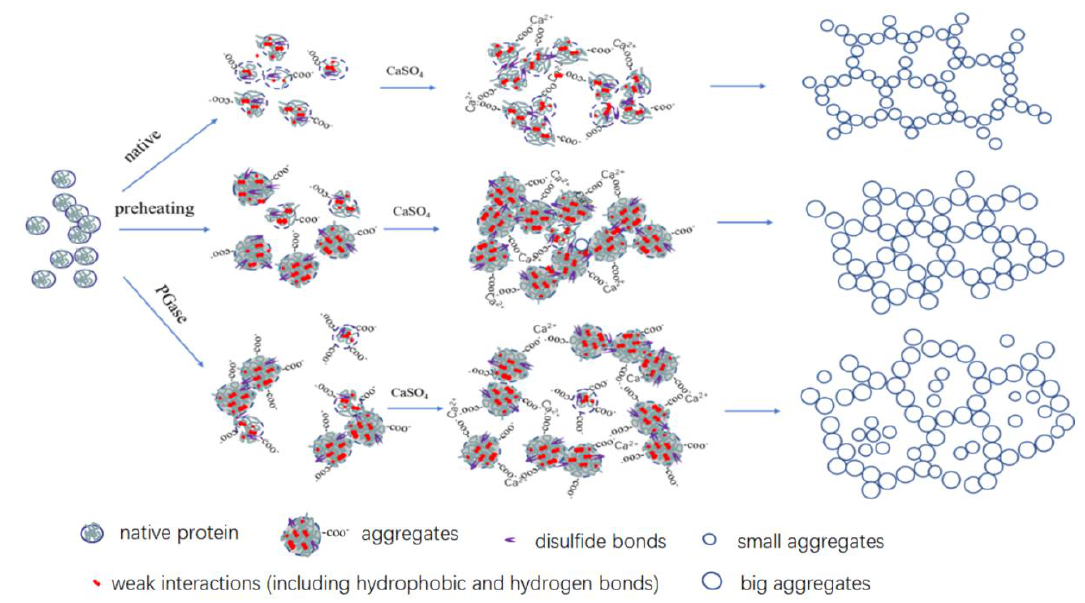
Figure 7. Supposed mechanism for the SPI with different heat treatment and deamidation levels on the gelation. Schematic: size and distance are not to scale. the gelation. Schematic: size and distance are not to scale.